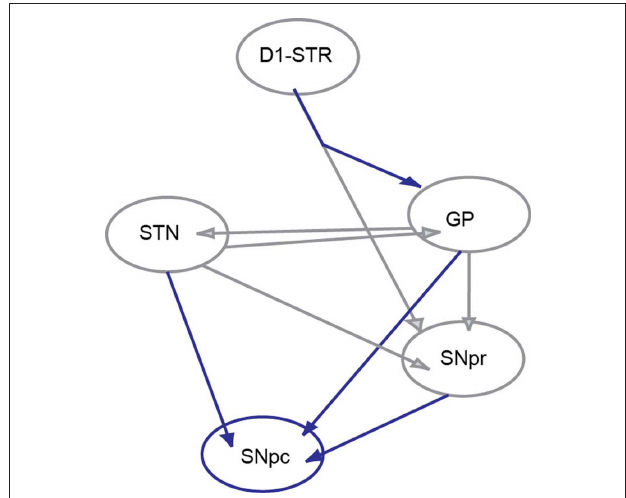
FiGure 1 | Circuit diagram. The six nuclei and their interconnections adapted from the Humphries et al. (2006) network model of the basal ganglia. The SNpc was added. The connections shown in gray are described in the original model while those in blue are added here. The connection from D1STR to the GP was added in accordance with anatomical data of Kawaguchi et